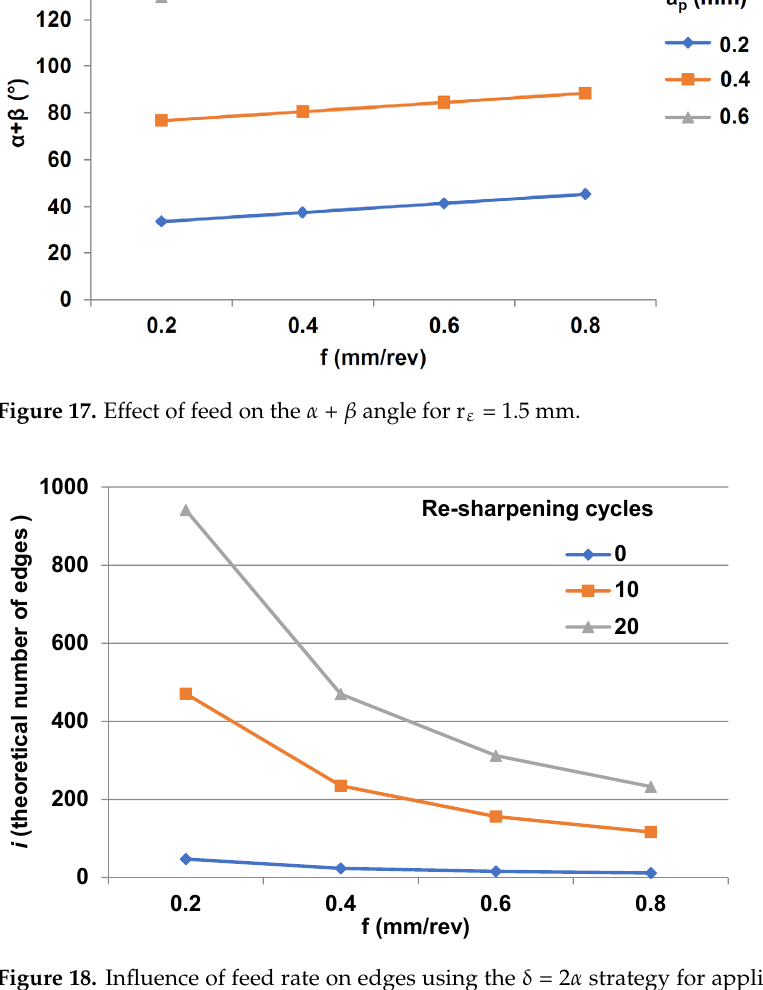
insert with a different number of resharpening cycles z.